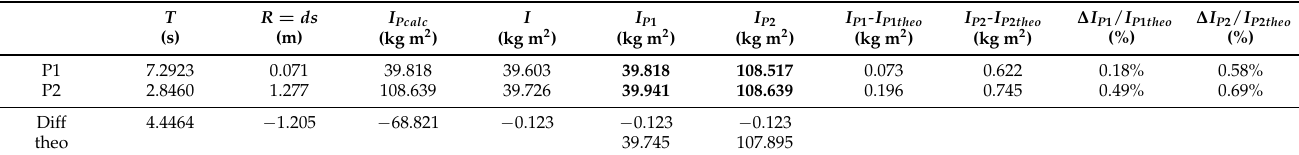
Table 8. Analysis of the results for the measurements for the moment of inertia for the empty swing—two different investigated pivot points P1 and P2—comparison to the theoretical values provided in Table